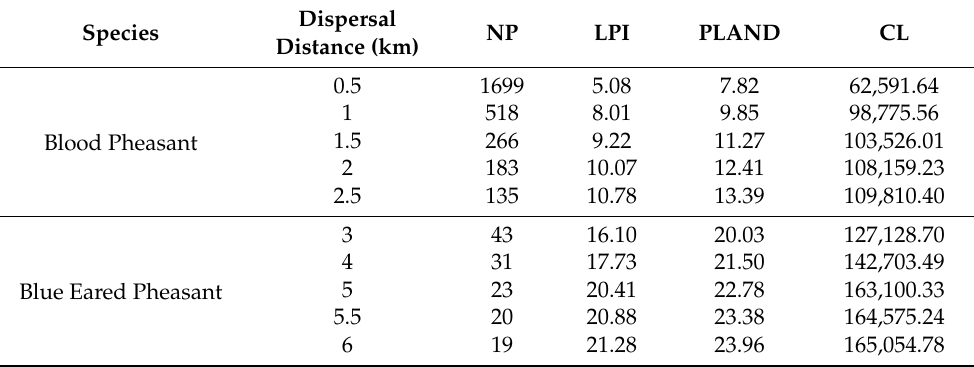
Table A3. Ecological niche fragmentation analysis. NP: number of isolated patches; LPI: largest patch index; PLAND: percentage of the landscape; CL: correlation length (or GYRATE_AM: area-weighted mean radius of